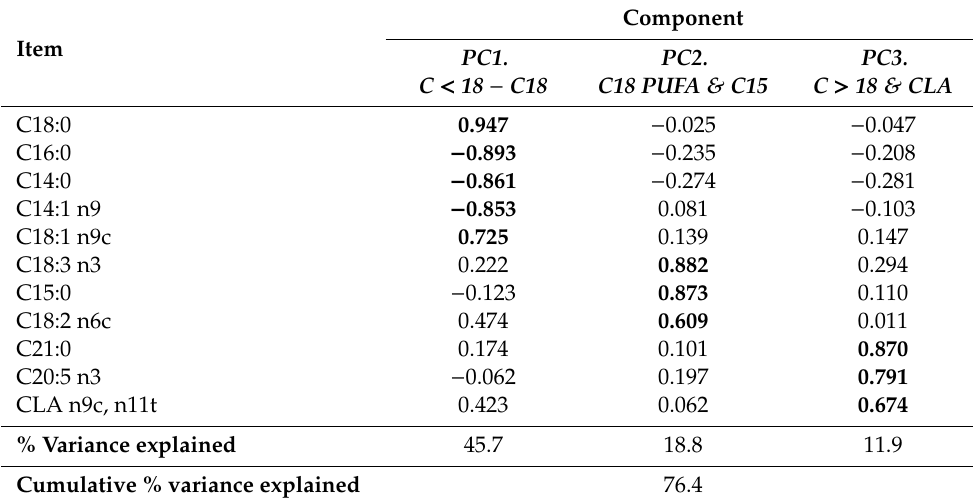
Table 3. Loadings of factors extracted with the principal component analysis.